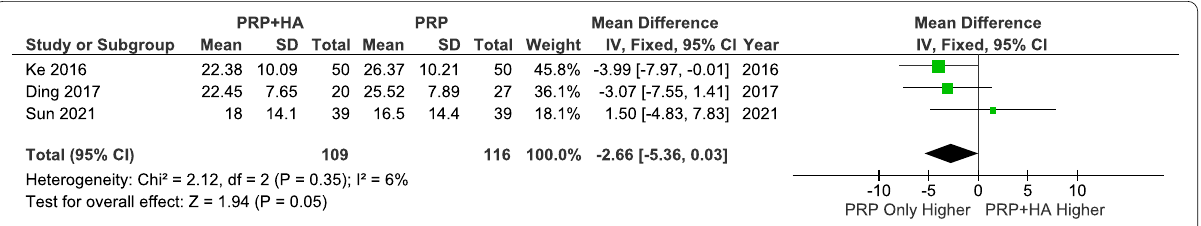
HA and PRP at 6 months after +